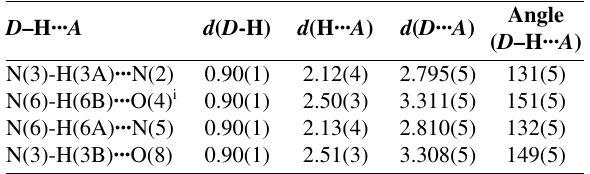
Table 3. Hydrogen bonding interactions (Å,